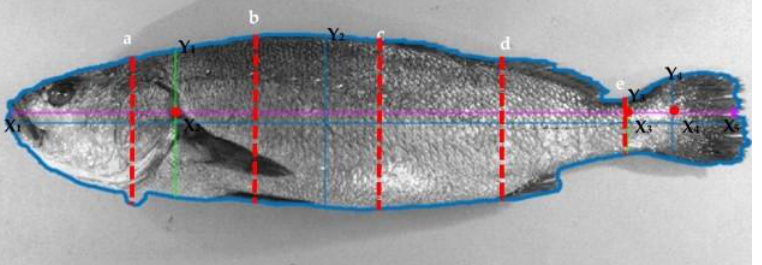
Figure 1. Image by IMAFISH_ML software. Lateral view, for the determination of non-invasive technological traits (NiT) of Argyrosomus regius : points X 1 , X 2 , X 3 , X 4 , and X 5 of the horizontal axis are used to determine longitudinal traits; Y 1 , Y 2 , Y 3, and Y 4 and a, b, c, d, and e are dorsoventral axes, which are be used to determine height traits. Table 2. The measured trait by IMAFISH_ML software.